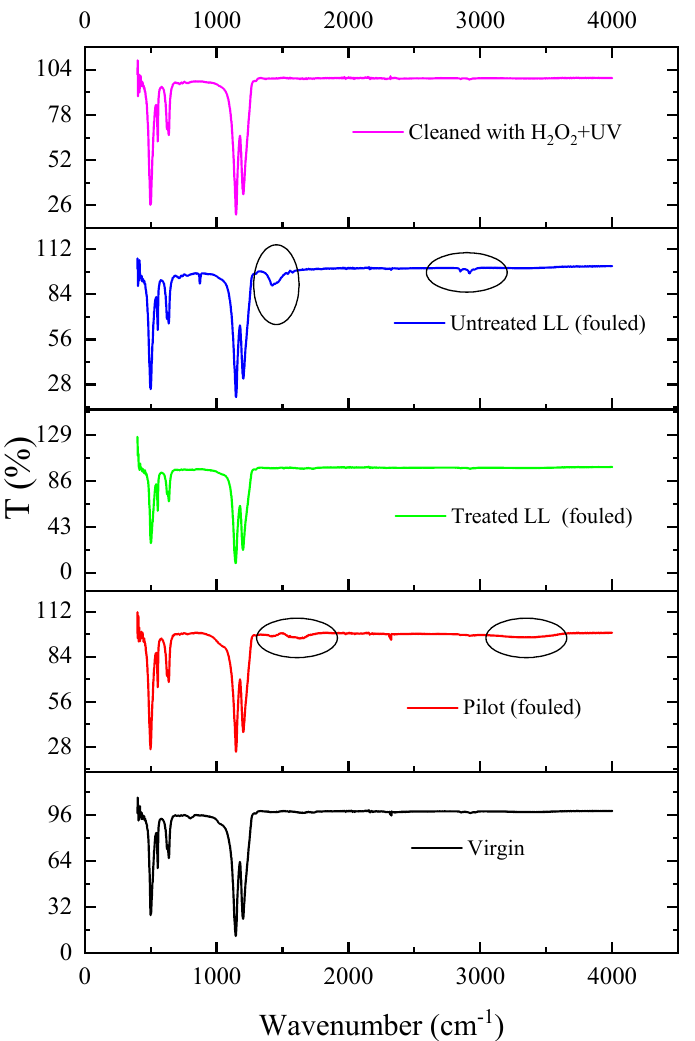
Figure 9. FTIR spectra of virgin, fouled, and cleaned membranes.